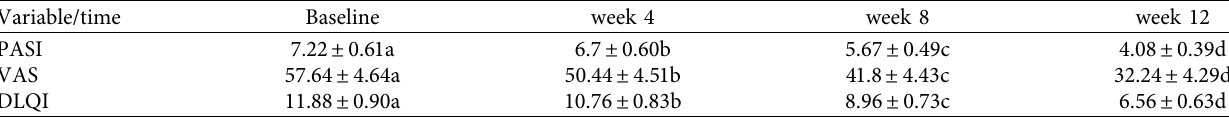
The difference letters in each row show significant difference at p < 0 . 05.